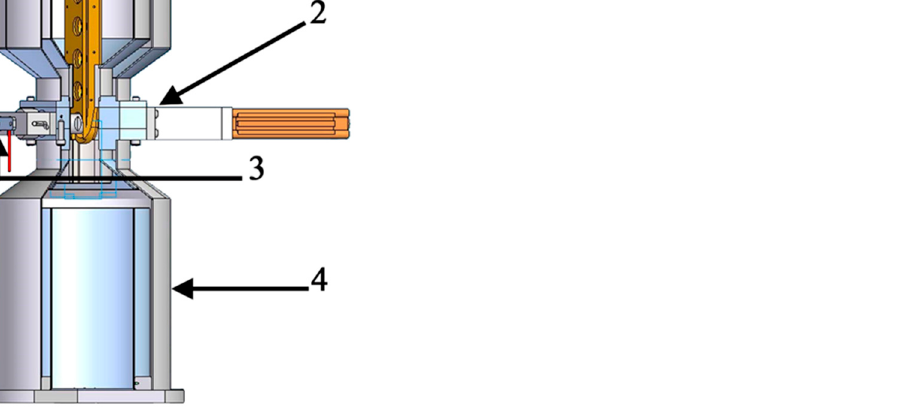
Figure 2. Research workstation for the acoustic emission (AE) tests: 1—guide, 2—ultrasonic sensor, 3—waveguides, and 4—tank.